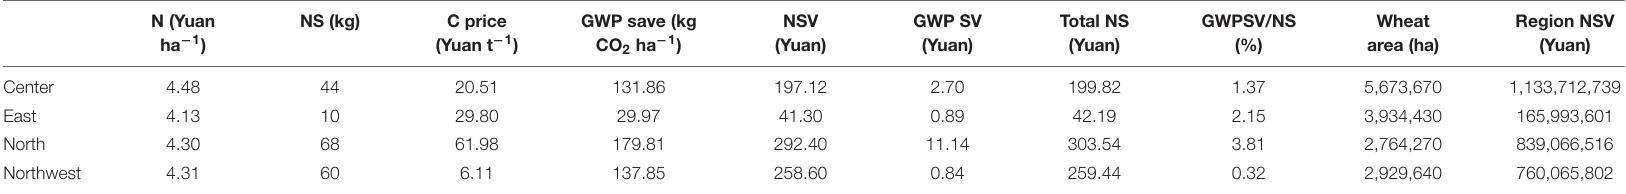
Center East North Northwest Refer to the details of nitrogen saving in Table 3